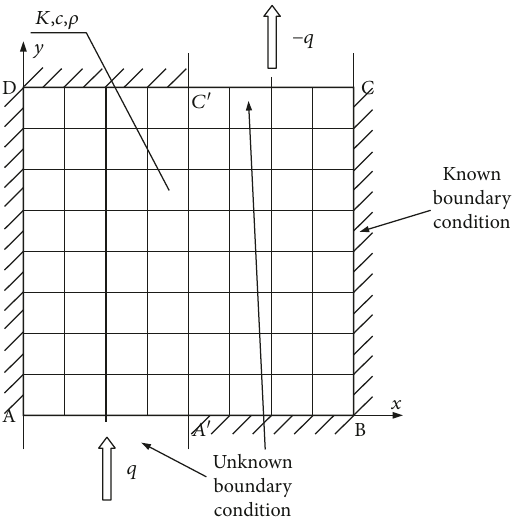
Figure 2: The model of square plate heat